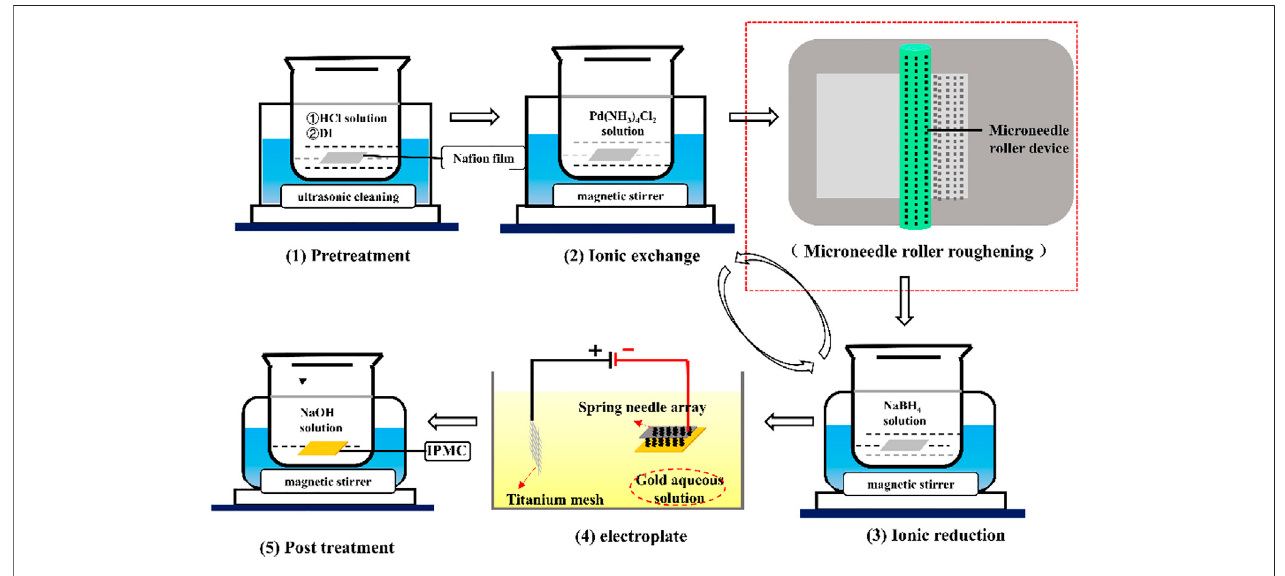
FIGURE 2 | Preparation process of IPMC.